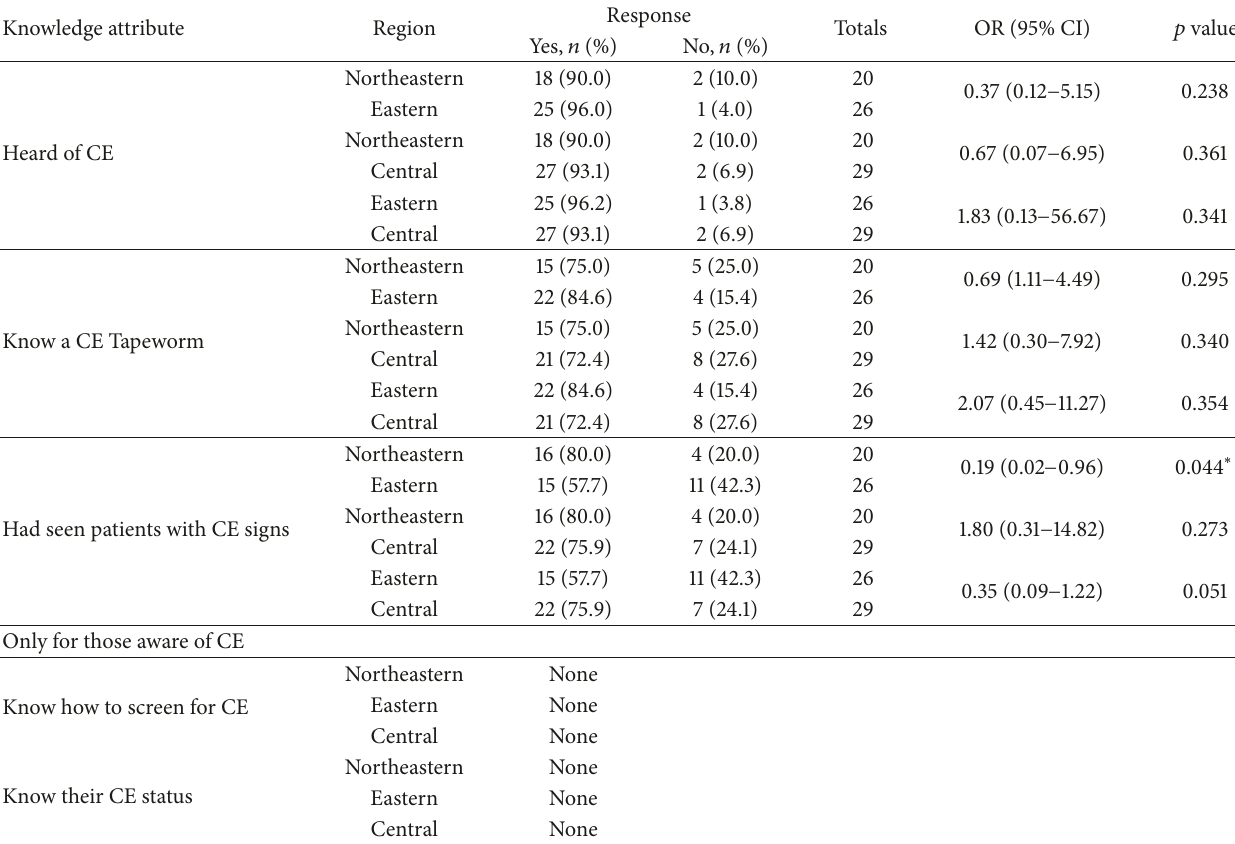
Table 4: Knowledge of the level of the health workers about CE